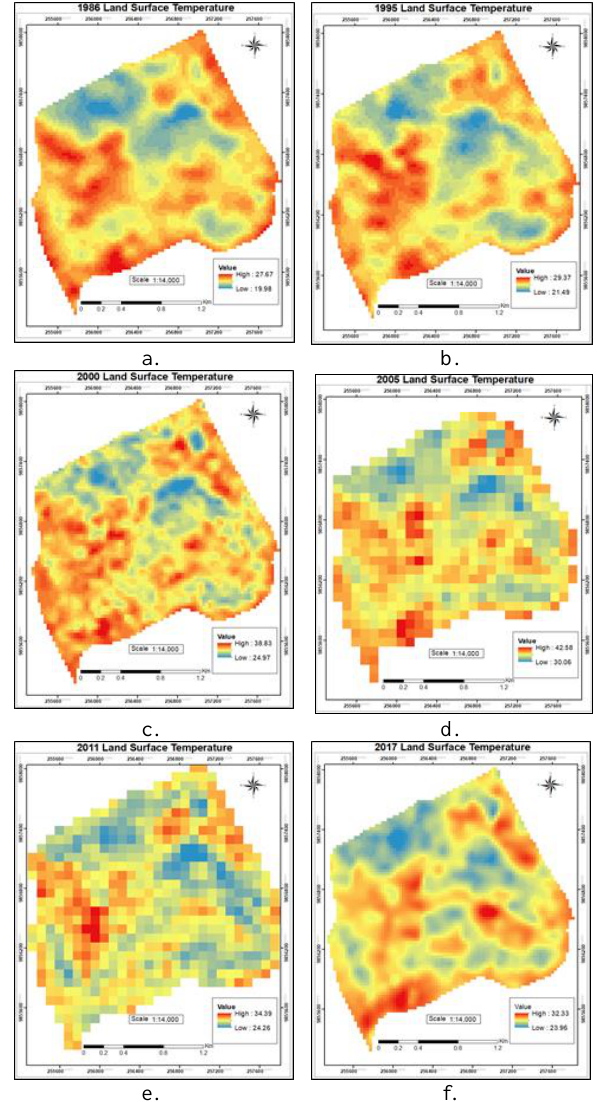
Figure 5: Morning land surface temperature for 1986(a), 1995(b), 2000(c), 2005(d), 2011(e) and 2017(f), in Upper Hill, Nairobi Open grassland land had the same LST with built-up areas, except for in 2005 where built-up areas had a mean LST of 35.4 0 C compared to 34.5 0 C in open grassland. Bare ground and that which does not have much vegetative cover tends to warm up faster compared to other land cover as it reflects incoming radiation. However, the amount of moisture in the soil affects the surface temperature (Tian et al ., 2012). Forest land cover and water bodies had a low LST with a mean of 23.5 0 C in 1986. Forests have a cooling effect due to evapotranspiration while water takes longer to warm up due to its large thermal heat capacity thus taking longer to warm up. Water had the lowest temperature ranges indicating minimal differences between the maximum and minimum calculated LST, while forests had the largest ranges in all years (figure